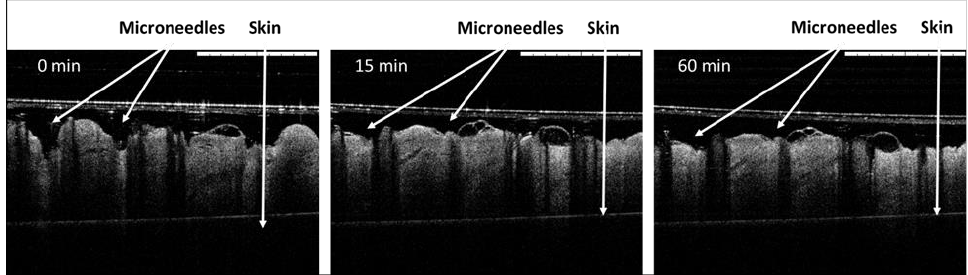
Figure 4. Optical coherence tomographic images of dissolving rLTB-loaded Gantrez ® AN-119 MNs in porcine skin. Images show in vitro dissolution at times 0, 15, and 60 min after insertion into porcine skin. White arrows indicate MNs or skin. Scale bars: 1 mm.